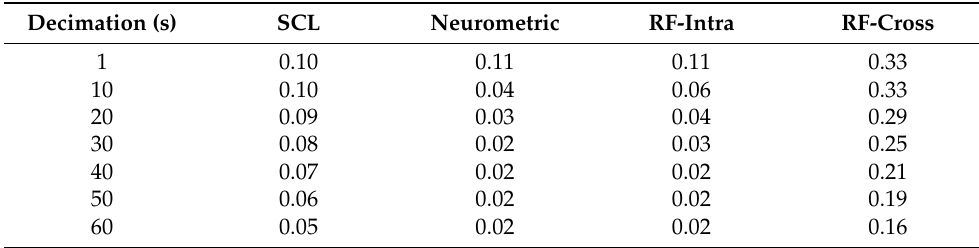
represented in green, the Random Forest calibrated intra-subject (RF-intra) in red, the Neurometric in blue, and the Skin Conductance Level (SCL) in orange. The points represent the outliers and the asterisk shows that p < 0.05 (the double-asterisk means p < 0.01) resulting from the Dunn’s post-hoc tests. Table 3. Measures of dispersion of the AUC values obtained from the driving experiment. Values of interquartile range have been reported for each decimation and each variable.